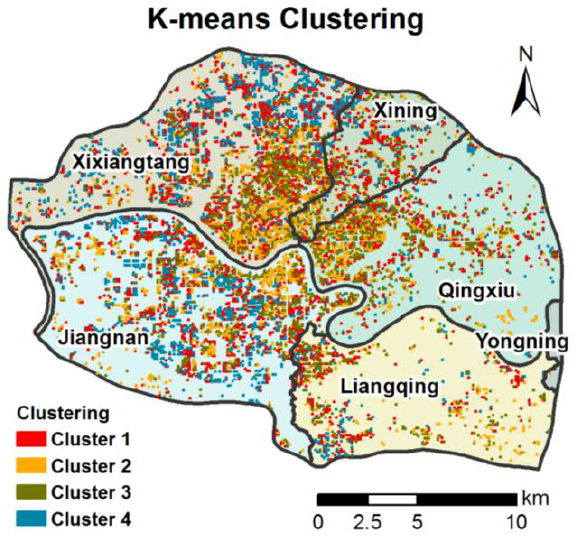
Figure 5. K-means clustering apply on Nanning